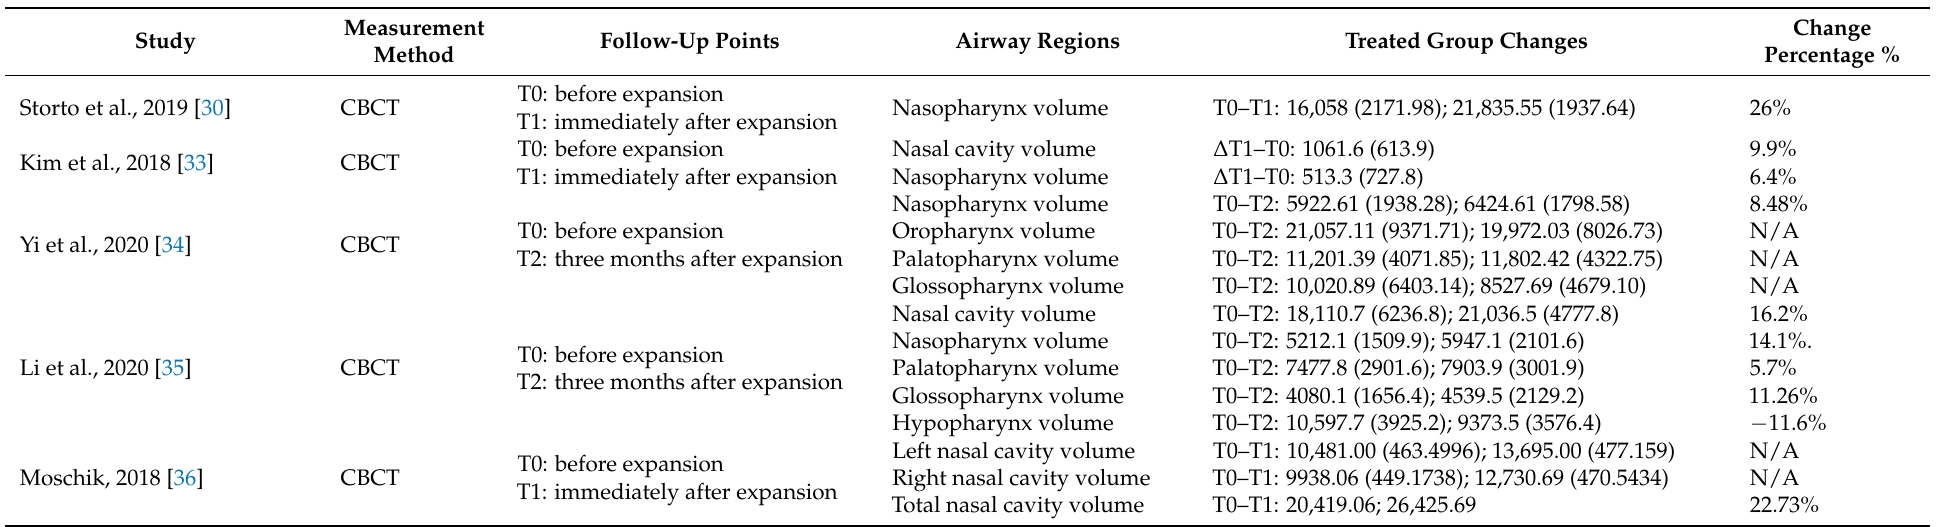
Table 3. Measurement method, follow-up points, airway regions, and outcomes of included